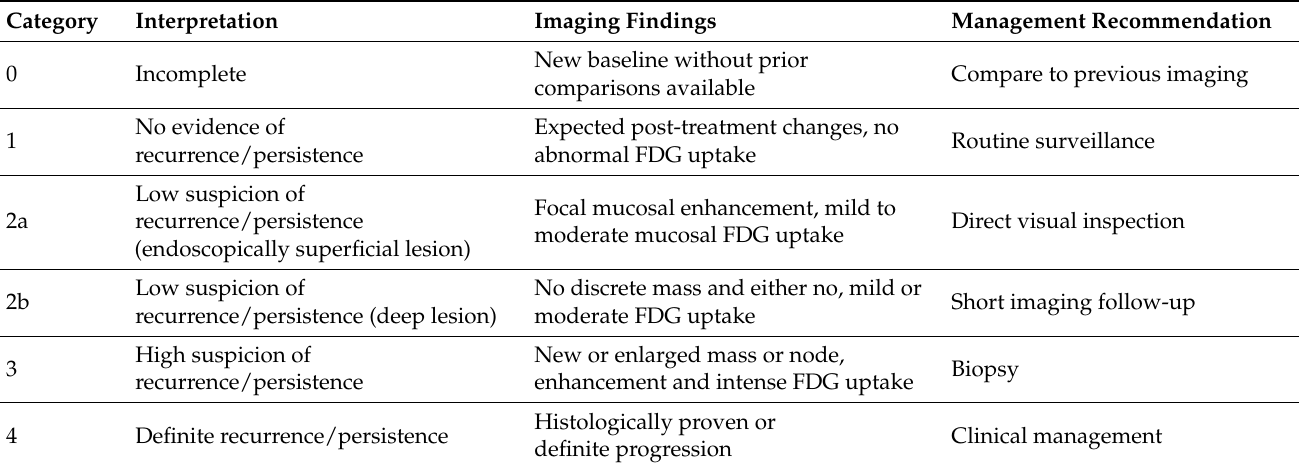
Figure 5. Early post ‐ treatment inflammatory change. ( a ) Axial fused PET CT images prior to therapy demonstrate a hypermetabolic, enlarged pathologic cervical node (white arrowhead): ( b ) On the first post ‐ treatment FDG PET ‐ CT scan, the node has decreased in size and activity following but is still evident (white arrowhead) and has surrounding inflammatory changes and fat stranding; ( c ) Follow ‐ up FDG PET ‐ CT scan 3 months later shows complete resolution of the node and inflamma ‐ tory stranding.